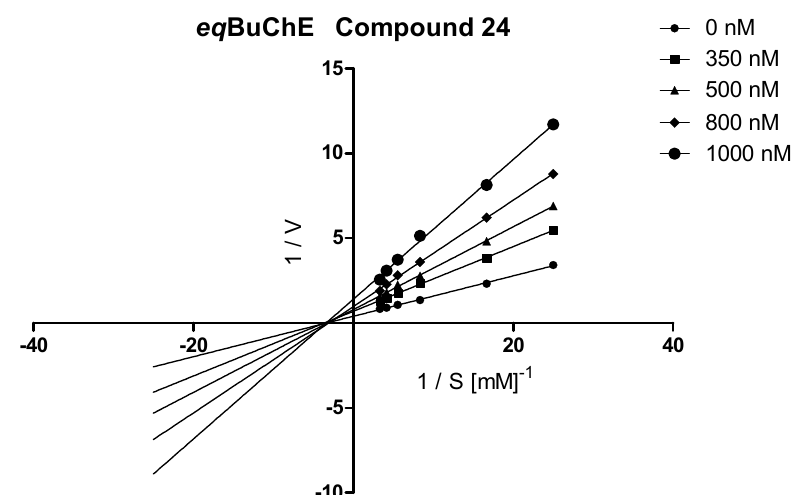
Figure 4. Lineweaver–Burk plot illustrating a noncompetitive type of eq BuChE inhibition by compound 24 . S = butyrylthiocholine; V = initial velocity rate.